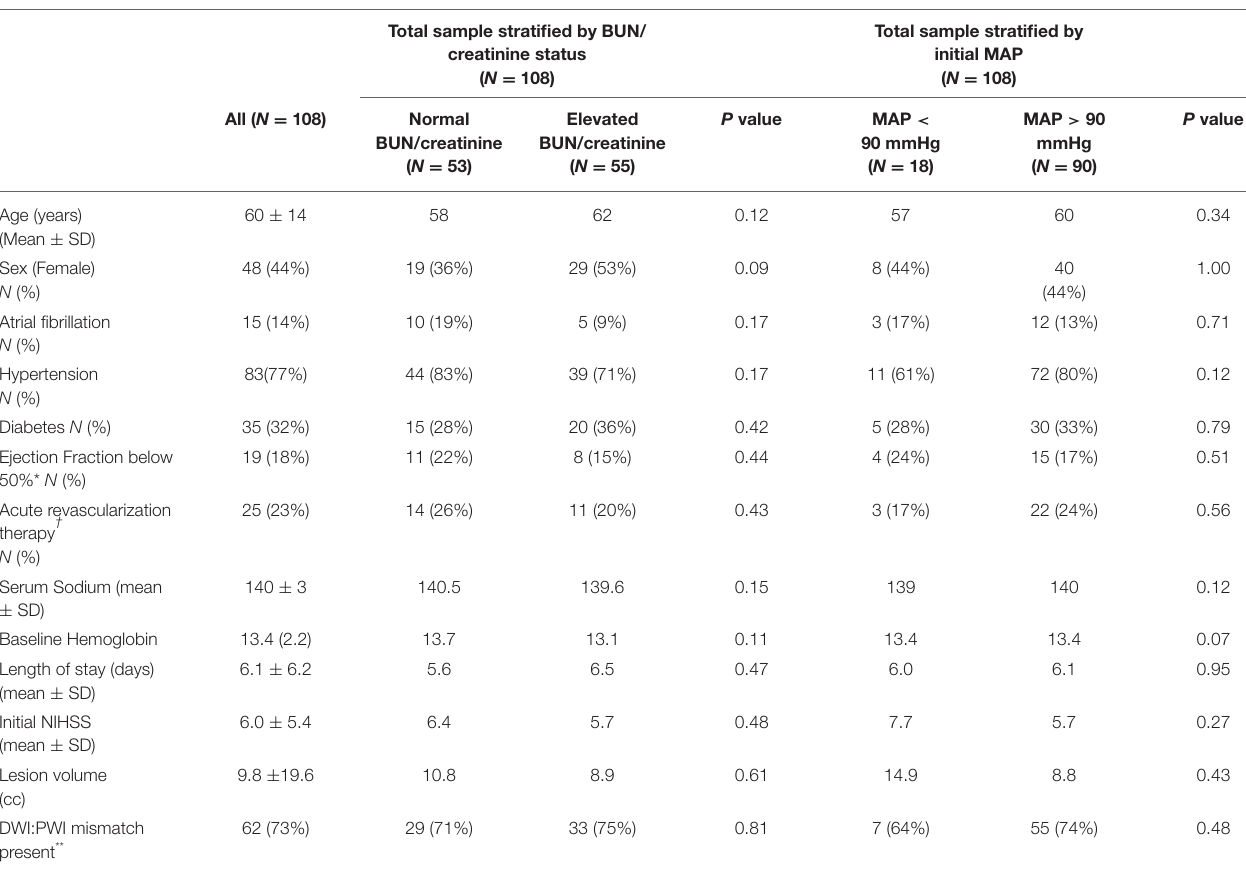
TABLE 1 | Demographics for the analytic sample.